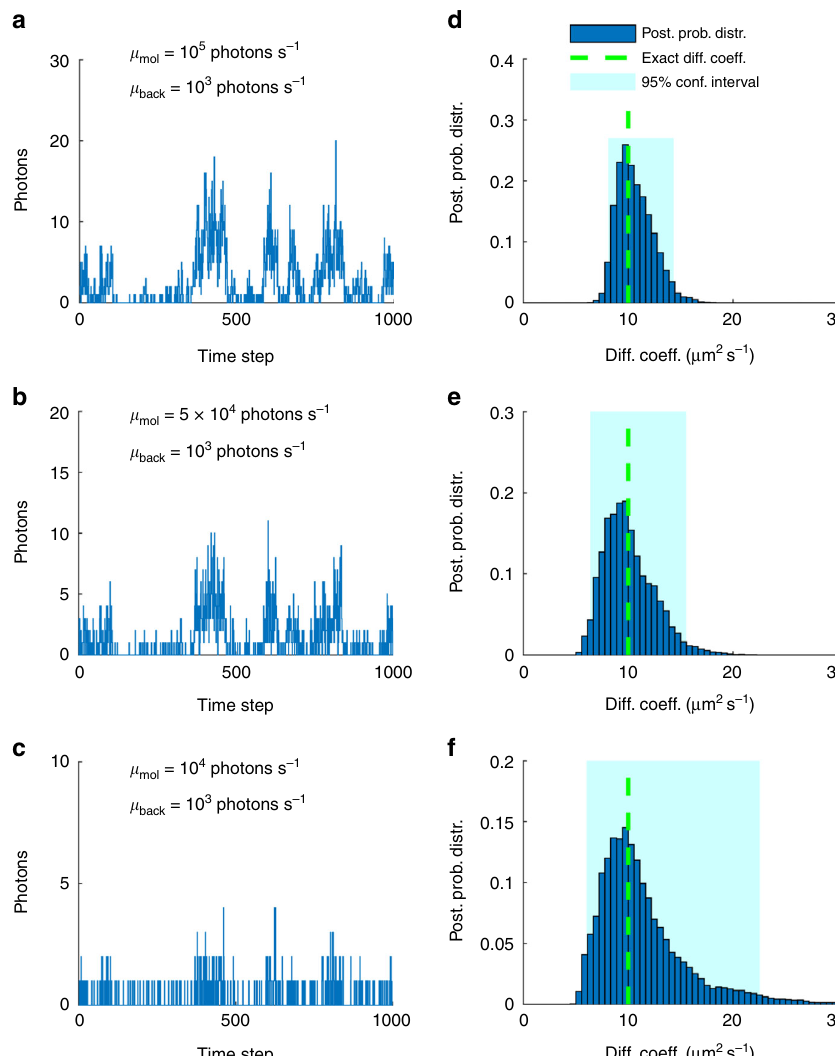
Fig. 3 Effects of molecular brightness. a – c Intensity traces produced by the same molecular trajectories under molecular brightness of 10 5 , 5 × 10 4 , and 1 × 10 4 photons s − 1 and background photon emission rate fi xed at 10 3 photons s − 1 . All traces are acquired at 100 μ s for a total length of 100 ms. d – f Posterior probability distributions and exact values of diffusion coef fi cients obtained from the corresponding traces. Shaded regions illustrate the 95% con fi dence